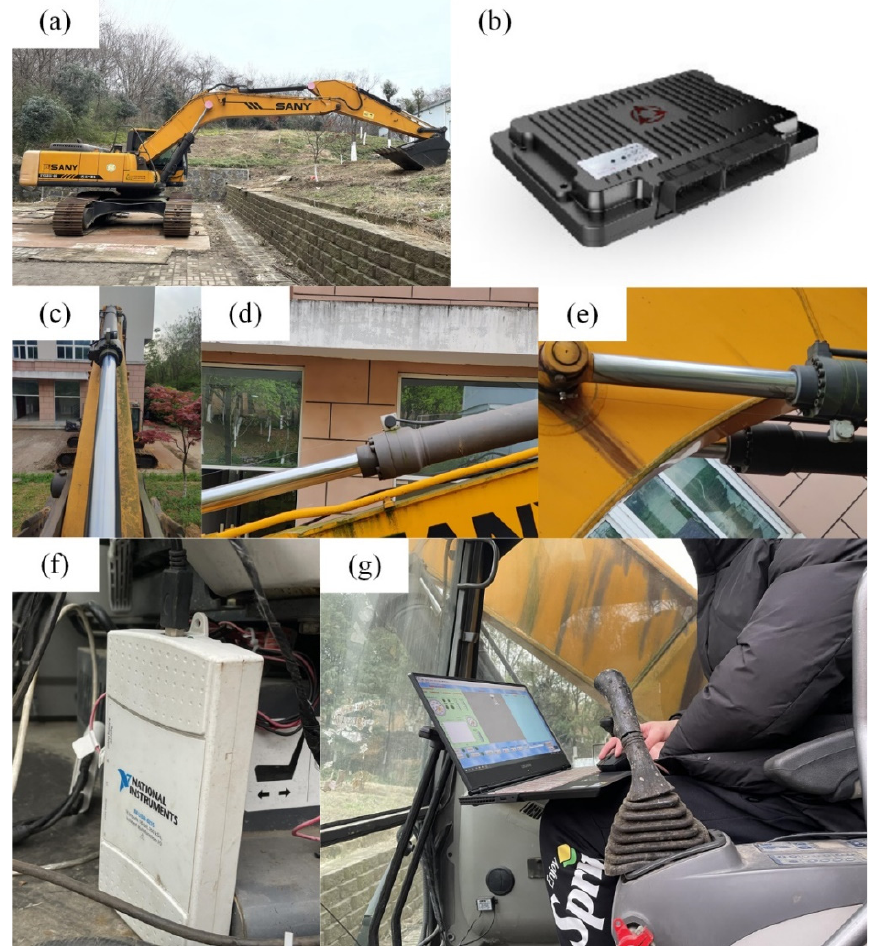
Figure 12. Laboratory 23-ton excavator trajectory control experiment platform: ( a ) 23-ton excavator, ( b ) 283H DSP controller, ( c ) displacement sensor of bucket, ( d ) displacement sensor of bucket, ( e ) displacement sensor of bucket, ( f ) NI 6215 DAQ card, ( g ) data collection system.